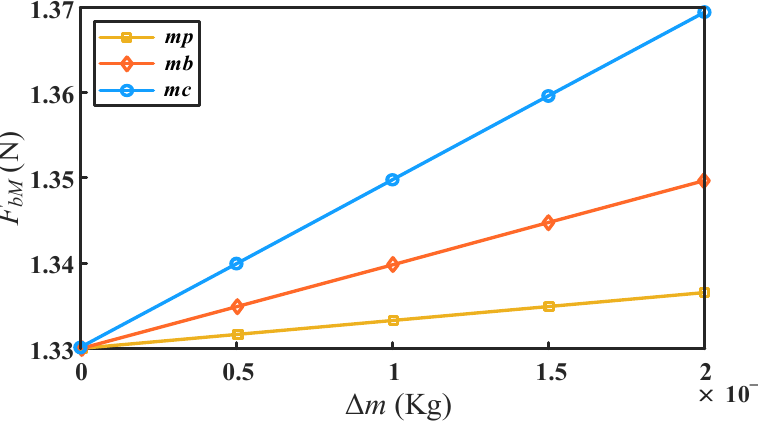
Figure 7. Influence of the bending stiffness of the flexure spherical hinge on the driving force of the mechanism.